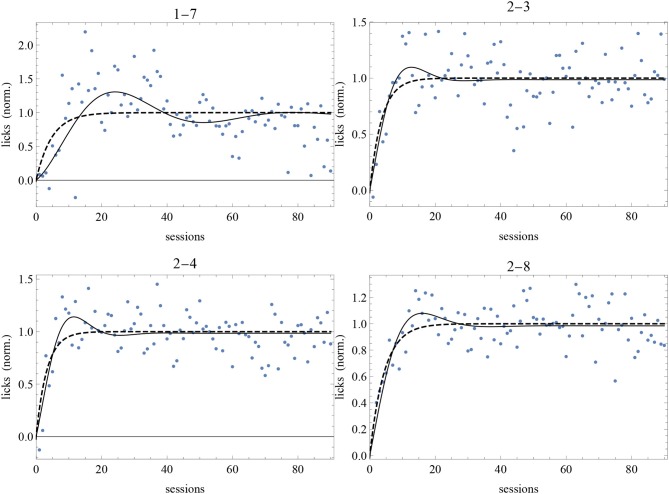
Best-fit of normalized data of our long experiment with the RW model (4) (dashed curve) and the DOM (8) with A = 0 with the parameter values of Table 4. Sessions are on the horizontal axis and normalized response is on the vertical axis.